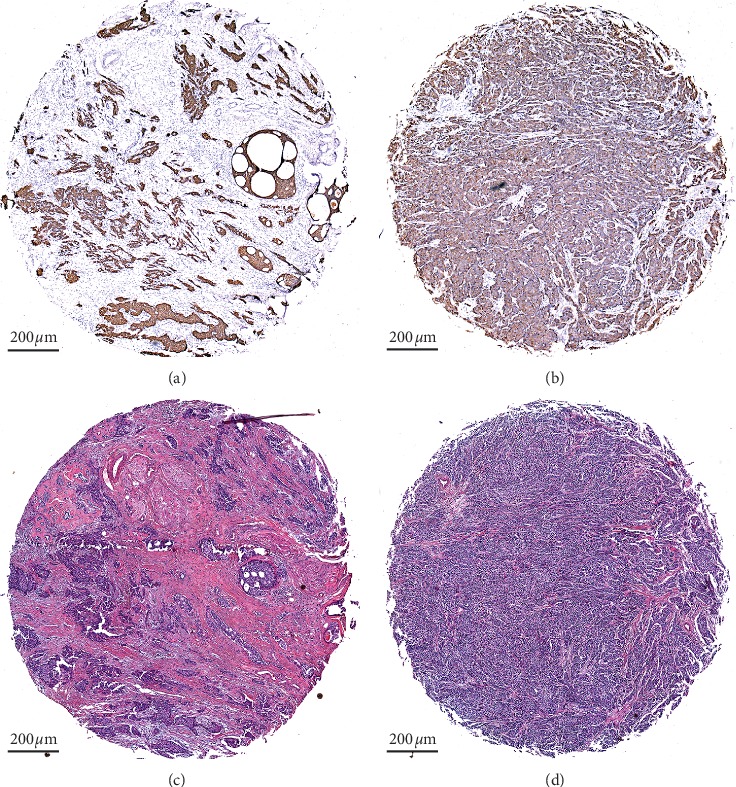
IHC staining and HE staining results in TMAs. IHC staining of CK could specifically label tumor areas with clear contrast (a, b). The differentiation of tumor and stroma in HE staining was not as clear (c, d). Examples of low TSR (high stroma) (a, c); examples of high TSR (low stroma) (b, d). HE,hematoxylin-eosin; IHC, immunohistochemistry; CK, cytokeratin; TSR, tumor-stromal ratio.